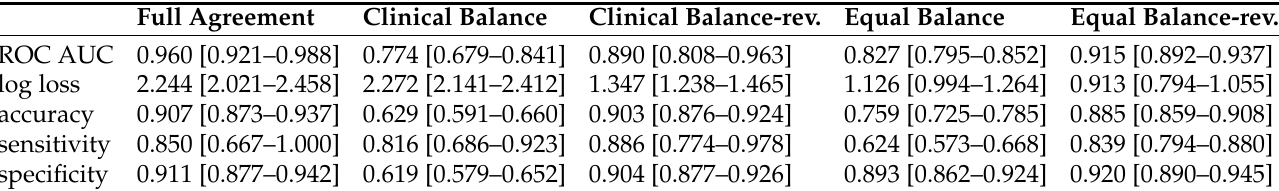
Figure 3. ROC curves for the three test sets. Table 2. ROC AUC, log loss, accuracy, sensitivity, and specificity results on the test